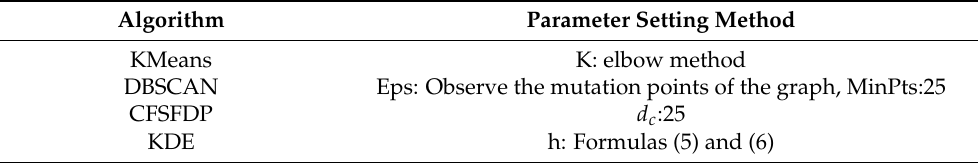
Table 6. The optimal parameters of each algorithm in the discovery of the positions of POIs (Points of Interest).